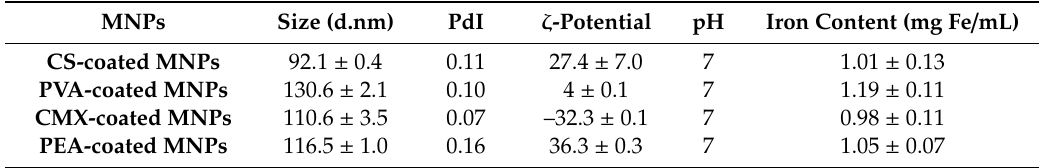
Table 3. Physicochemical features of MNPs suspended in water. Properties of MNPs determined via dynamic light scattering (DLS), using pH indicator papers and atomic absorption spectroscopy (AAS). Mean and standard deviation of the mean (n = 3). PdI, polydispersity